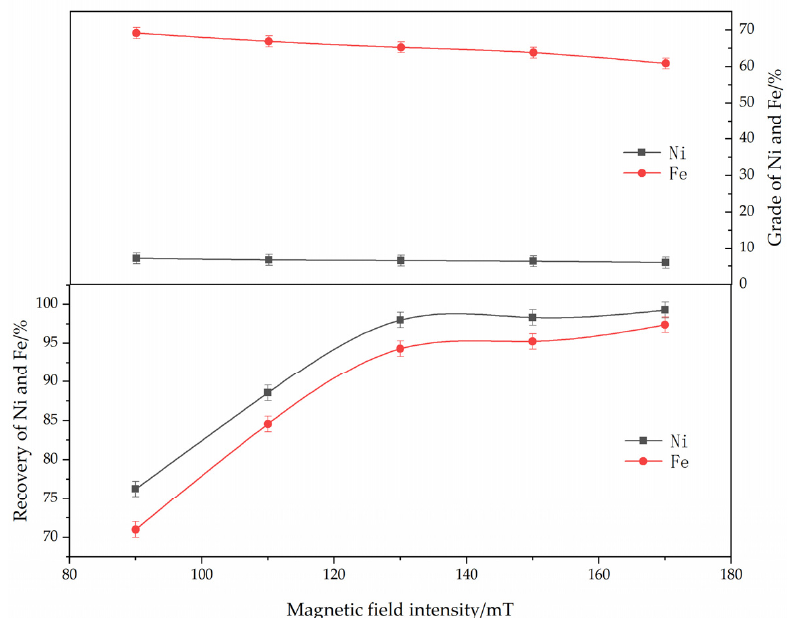
Figure 9. The effect of magnetic separation on the grade and recovery of nickel and iron in ferronickel concentrate. (The ferronickel concentrate dosage was 30 wt.%, The reducing temperature was 1250 °C, the roasting duration was 60 min, the reductant dosage was 8 wt.%).